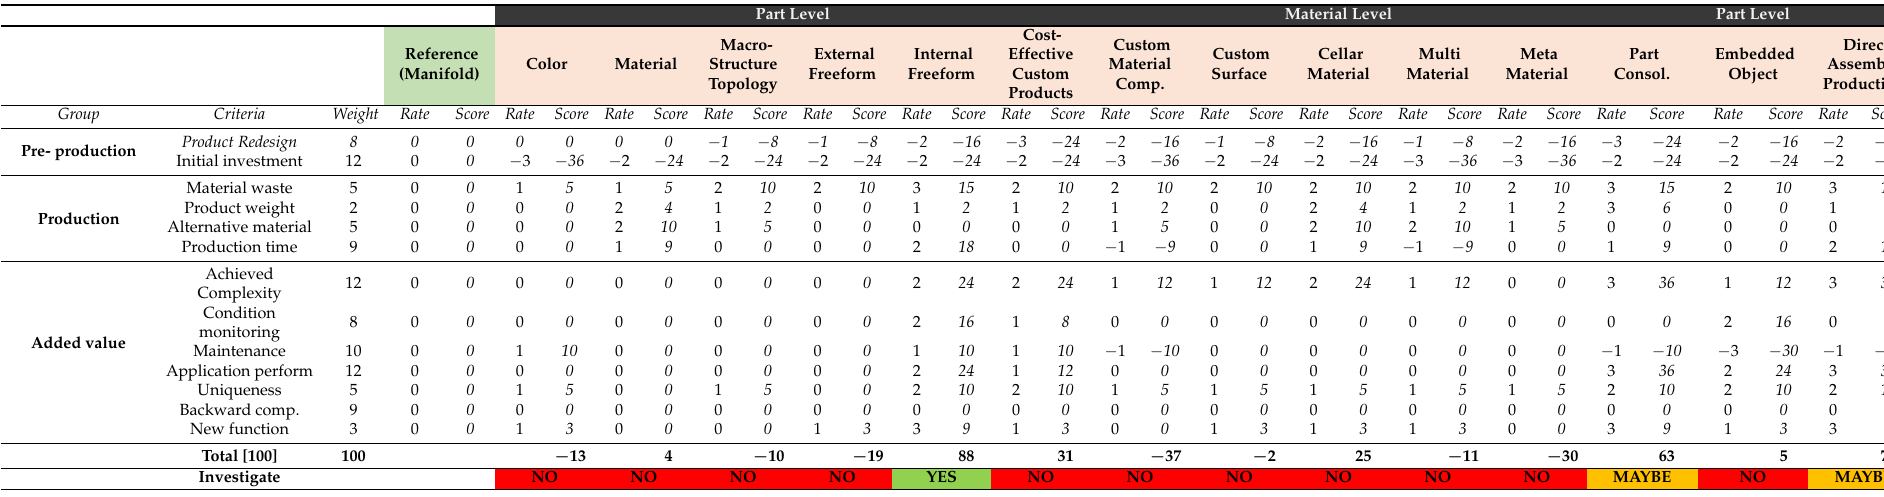
Table 2. Decision matrix for